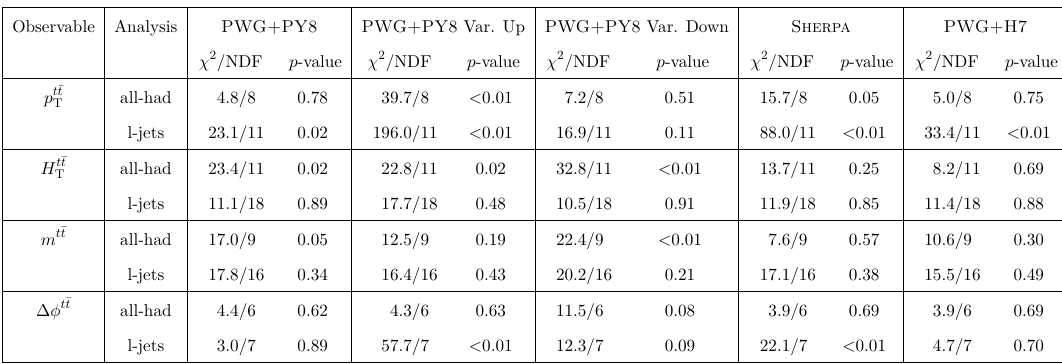
Table 17 . Selection of measured particle-level absolute single-differential cross-sections for all- hadronic and single lepton analyses for predictions from several MC generators. For each prediction, a χ 2 and a p -value are calculated using the covariance matrix of the measured spectrum. The number of degrees of freedom (NDF) is equal to the number of bins in the